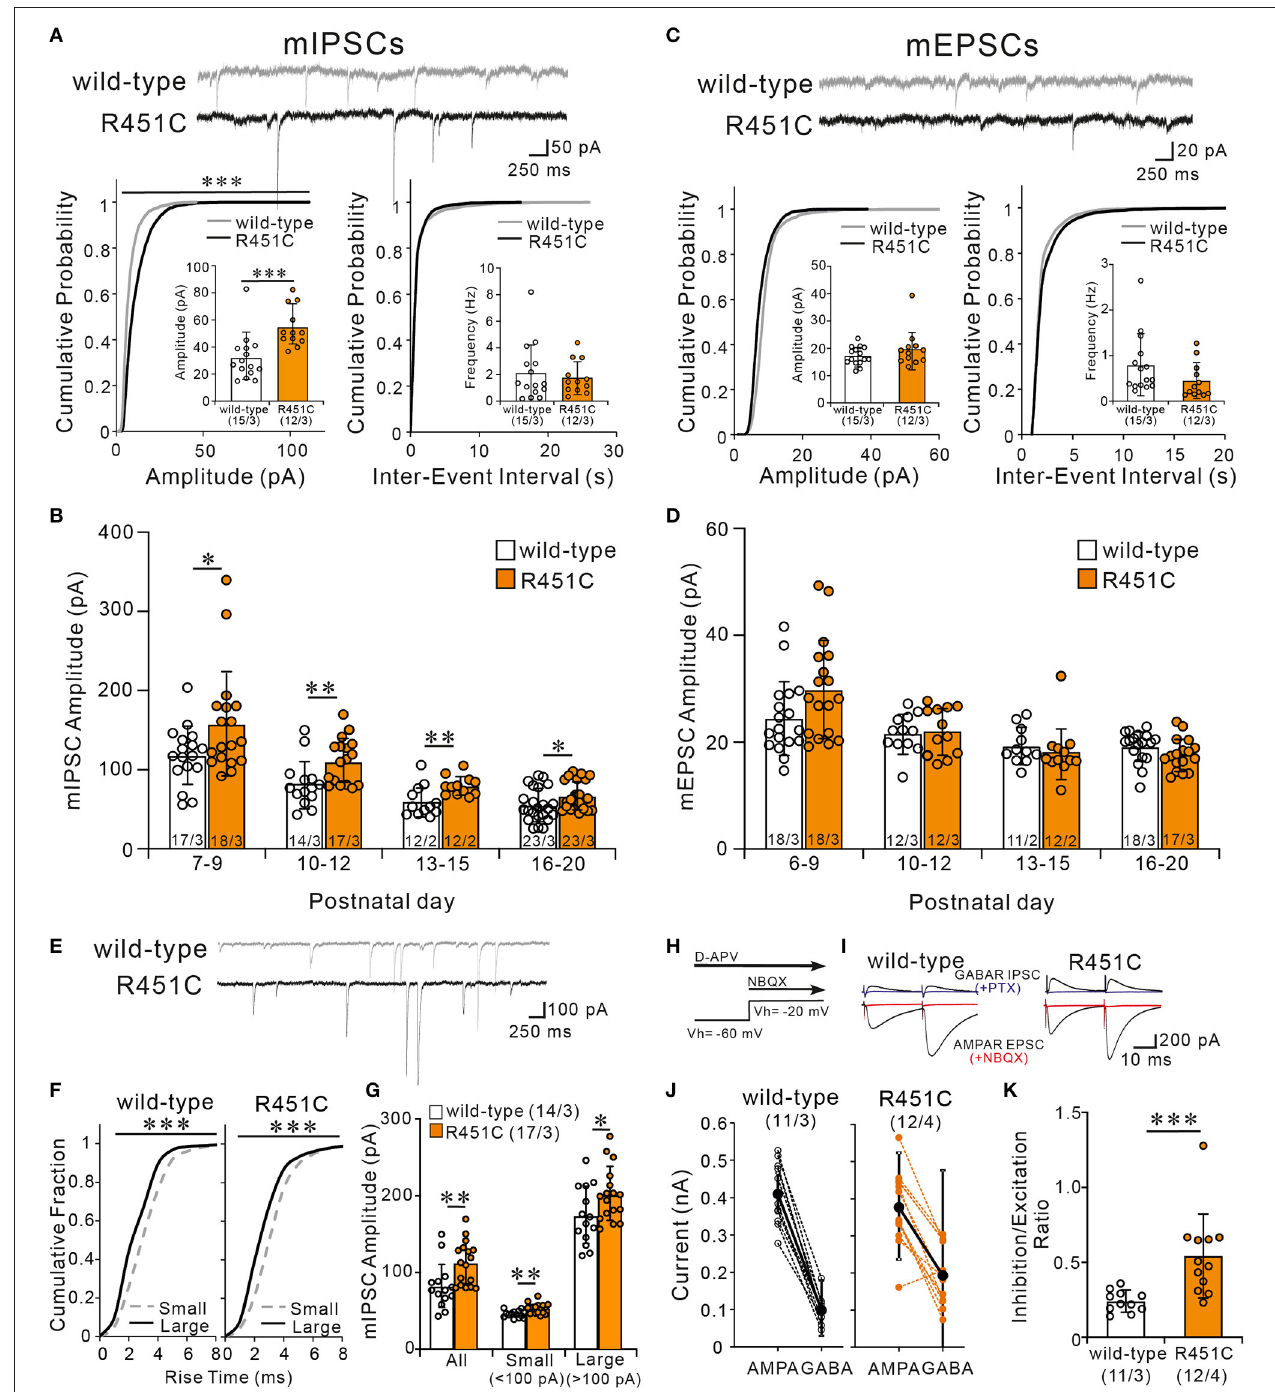
FIGURE 6 | The NLGN3-R451C mutation causes the enhancement of inhibitory synaptic transmission and the elevation of inhibition/excitation ratio of synaptic inputs to PCs. (A) Representative traces of mIPSC recorded from PCs of wild-type (upper trace) and NLGN3-R451C mutant (lower trace) mice (top) at Vh of − 70mV in the presence of 1 µ M tetrodotoxin, 10 µ M NBQX, and 5 µ M R-CPP ( N = 3/group). Scale bars, 250ms and 50pA. Cumulative distribution plots and summary bar graphs for the mIPSC amplitude (lower left; inset shows the average mIPSC amplitude) and for the inter-event interval (lower right; inset shows the average mIPSC frequency) in PCs of wild-type and NLGN3-R451C mutant mice aged P21–P35. For the mIPSC amplitude, *** p < 0.0001 by Kolmogorov-Smirnov test in the cumulative distribution plot and *** p = 0.0002 by Mann-Whitney U test in the bar graph. For the inter-event interval, p = 0.99 by Kolmogorov-Smirnov test in the cumulative distribution plot and p = 0.9 by Mann-Whitney U test in the bar graph. (B) Summary graph for the mIPSC amplitude of wild-type (open columns) and NLGN3-R451C mutant (orange columns) mice at indicated ages. Note that the mean amplitudes of mIPSCs in NLGN3-R451C mutant mice are significantly larger than those